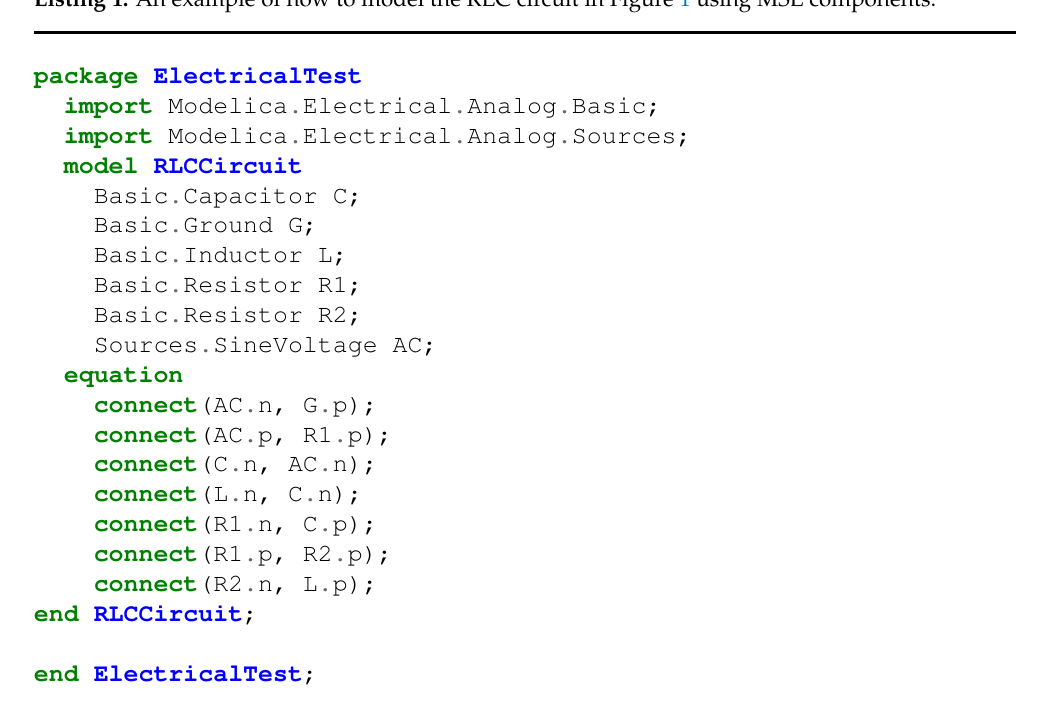
Listing 1. An example of how to model the RLC circuit in Figure 1 using MSL